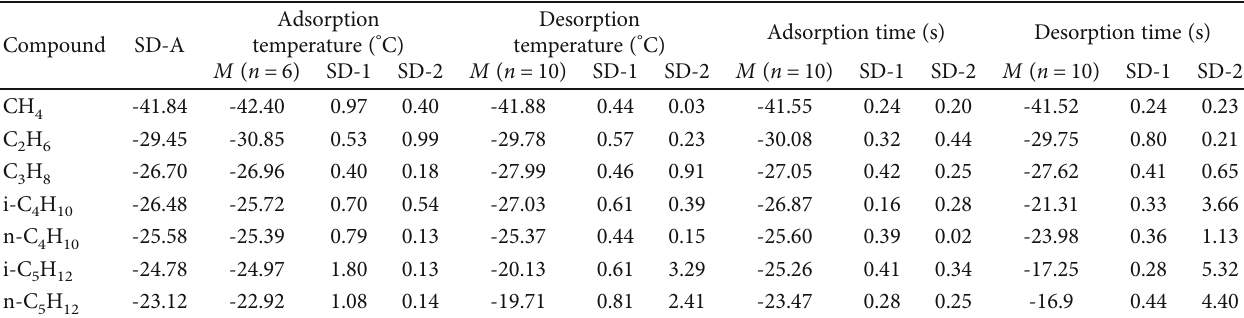
Figure 3: Peak areas at di ff erent experimental conditions: (a) the adsorption peak areas with adsorption temperatures ranging from 0 to 40 ° C; (b) the adsorption peak areas at di ff erent desorption temperatures from 250 to 350 ° C; (c) the adsorption peak areas at di ff erent adsorption times ranging from 2 to 5 minutes; (d) the adsorption peak areas at di ff erent desorption times ranging from 2 to 7 minutes. Table 3: δ 13 C ratios of standard natural gas sample and its SDs at di ff erent